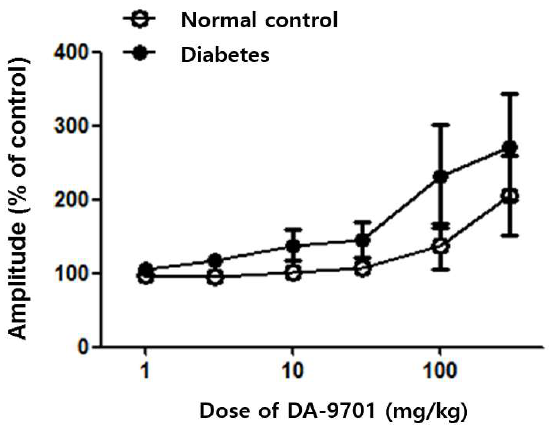
Figure 8. Effect of DA-9701 on colonic motility in normal control and streptozotocin-induced diabetic mice. DA-9701 administration showed a dose-dependent increase in the amplitude of spontaneous phasic contractions in the colon in normal controls and streptozotocin-induced diabetic mice, without significant difference between the two groups. (n = 10 in each group). 3.4. Small Intestinal Transit and GE Rate in the STZ-Induced Diabetic Mice The intestinal transit decreased significantly in STZ-induced diabetic mice compared to normal controls (43 ± 7% vs. 67 ± 8%, p < 0.05, Figure 9). Figure 9. Effect of DA-9701 on intestinal transit in streptozotocin-induced diabetic mice. Intestinal transit was significantly decreased in streptozotocin-induced diabetic mice compared to normal control and improved in DA-9701 treatment group compared to placebo (3% HPMC-treated) group. The intestinal transit was 67 ± 4.0%, 60 ± 4.2%, 70 ± 6.6% in the treatment with 1 mg/kg, 3 mg/kg, and 10 mg/kg of DA-9701, and 49 ± 4.0% placebo groups, respectively. In particular, the intestinal transit improved significantly with 1 mg/Kg and 10 mg/kg of DA-9701 treatment compared to pla- cebo (n = 10 in each group) * p < 0.05. The GE rate was also significantly delayed in the diabetic group compared to that in the normal control group (43 ± 10% vs. 62 ± 12%, p < 0.05, Figure 10).